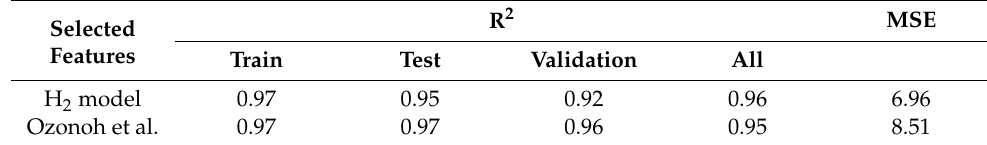
Table 3. Performance comparison between the H 2 model and that of Ozonoh et al. [16].